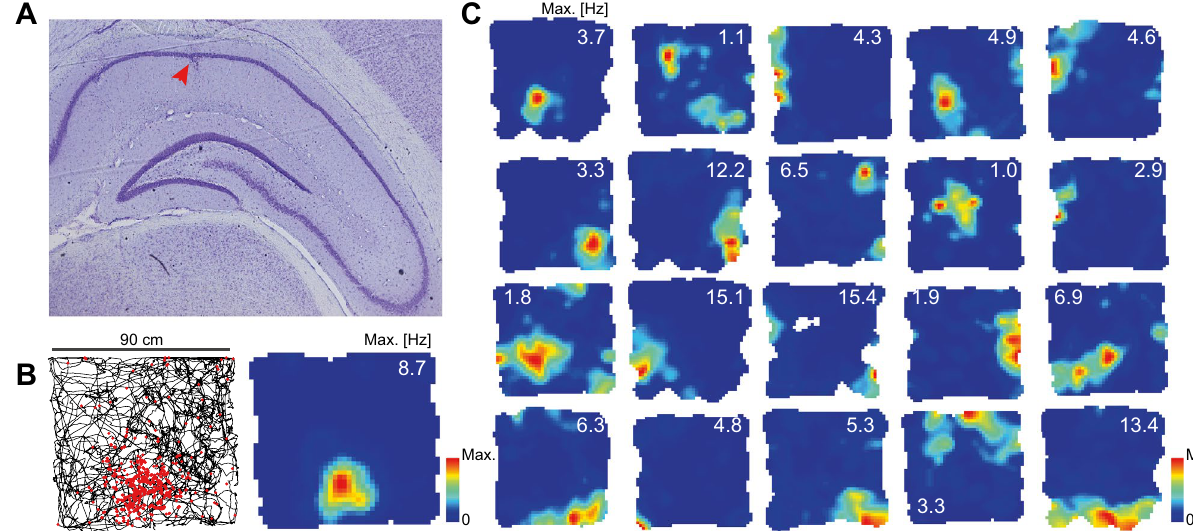
Figure 1. Place cells in the CA1 subfield of the degu hippocampus. ( A ) Representative example of cresyl violet stained histology showing the dorsal hippocampus and the recording site (red arrow). ( B ) Map of a principal cell with spatial field. Left: trajectory in a square environment (black) and positions where spikes were fired (red dots). Right: firing rate (color coded) version of the same map (maximum firing rate indicated). ( C ) Similar maps of all other recorded cells with significant spatial